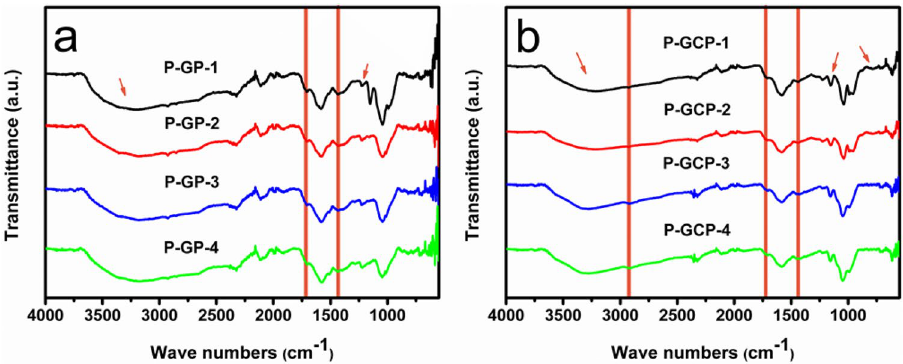
Figure 4. FT-IR spectra of ( a ) P-GP binary artificial nacre and ( b ) P-GCP ternary artificial nacre.